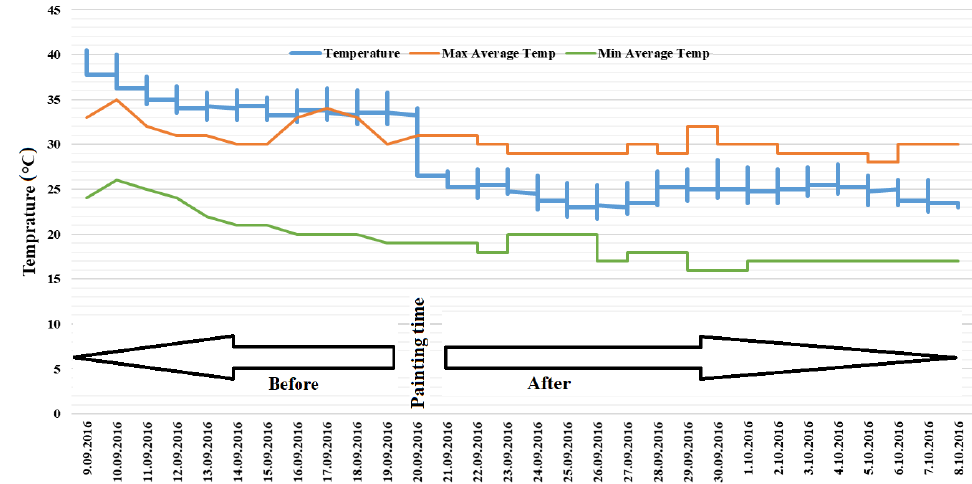
Figure 11. Measurement values of daily average and maximum/minimum temperatures for TR5.